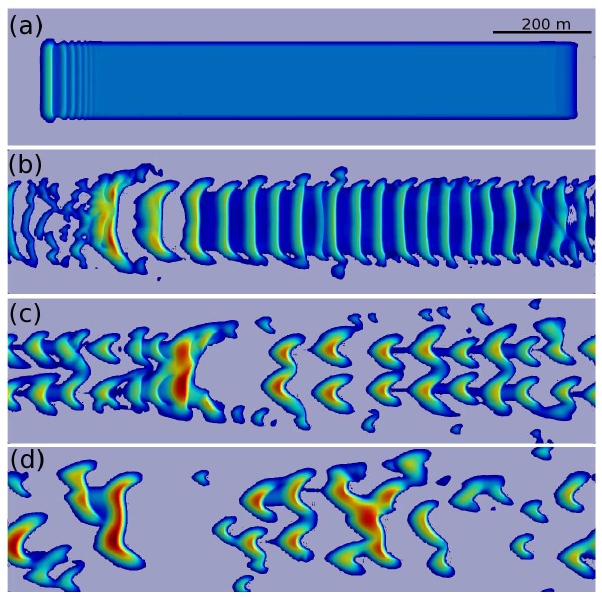
Fig. 3. (Color online) Snap shots of the dune field evolution begin- ning with a uniform sand bed under periodic boundary conditions. Wind blows from left to right. Illustrations reprinted from Duran et al. (2010) with authorization.